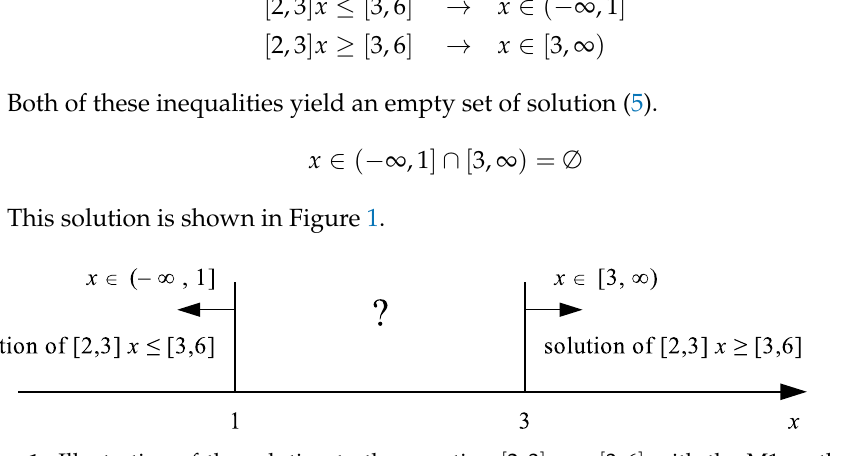
Figure 1. Illustration of the solution to the equation [ 2,3 ] x = [ 3,6 ] with the M1 method which transforms it into two inequalities [ 2,3 ] x ≤ [ 3,6 ] and [ 2,3 ] x ≥ [ 3,6 ] .